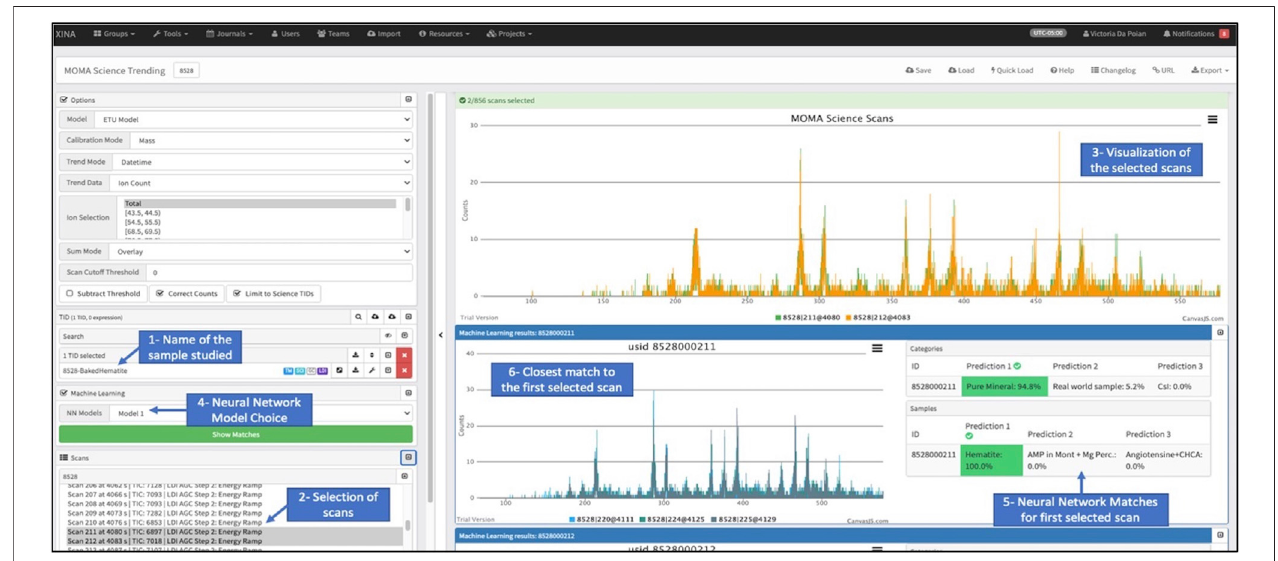
FIGURE5| The “ CustomerAlsoLiked ” (CAL)interfaceistheresultingsoftwareusedbythescientists.Itshowstheinformationaboutthemassspectraunderstudy [name(rectangle 1),selectedspectra(rectangle2),and visualizationofthemassspectra(rectangle3)].ItalsoshowstheoutputsoftheNN(selected model[rectangle4), predictions (rectangle 5)], as well as the closest mass spectra that was already in our dataset (rectangle 6). With this information, the scientists can make a fi rst brief analysis of the newly studied sample and potentially use previous operations in their decision-making process.